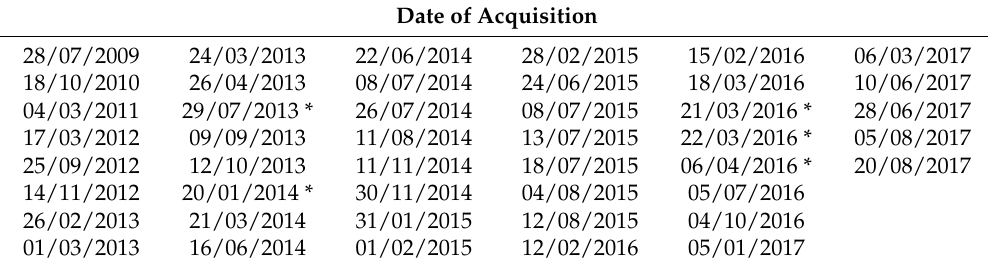
Table A3. VHR optical satellite data (© 2018 DigitalGlobe; * © 2018 CNES/Airbus) accessed through Google Earth covering the UNESCO WHS of Cyrene and the modern town of Shahat (Libya) and referred to in Section